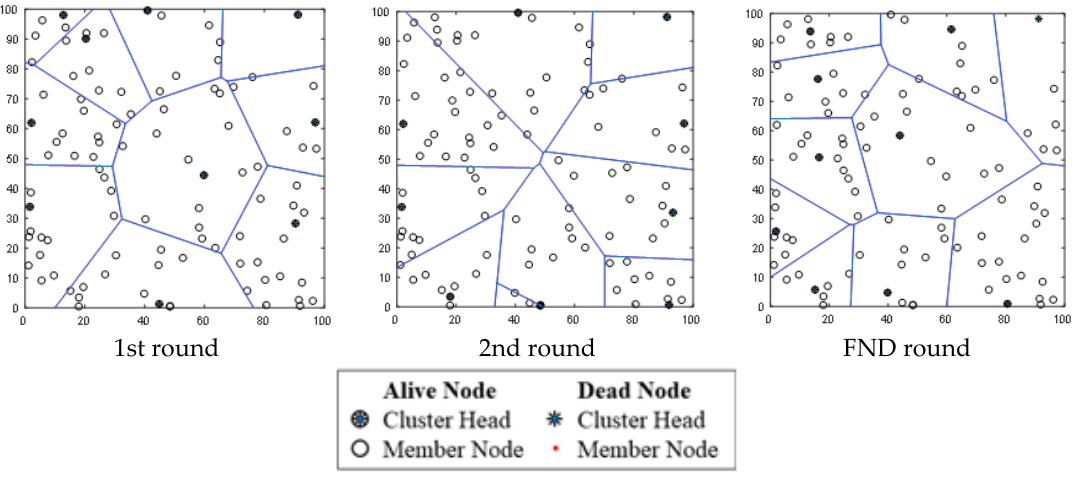
Figure 14. Constellation of nodes and clusters’ configuration.